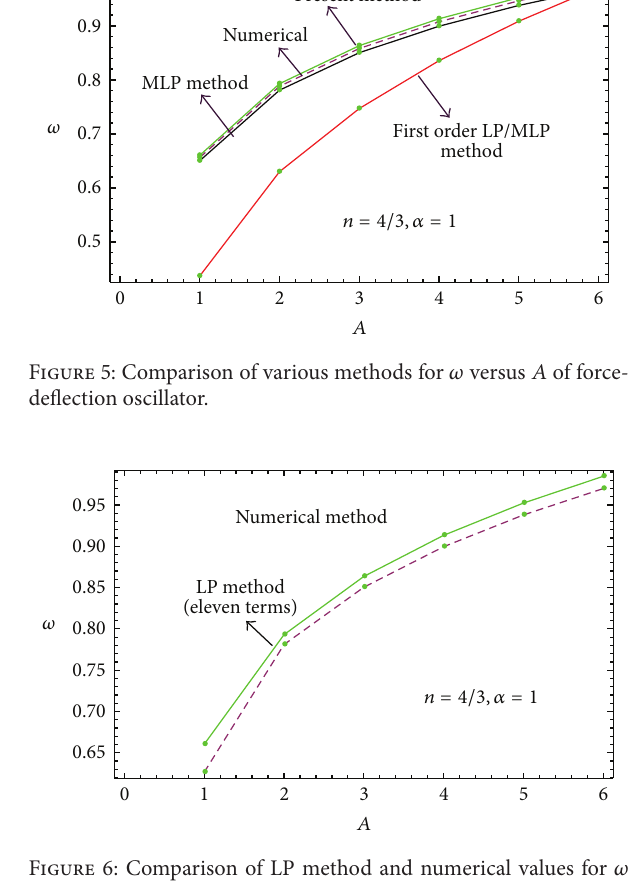
Figure 6: Comparison of LP method and numerical values for 𝜔 versus 𝐴 of force-deflection